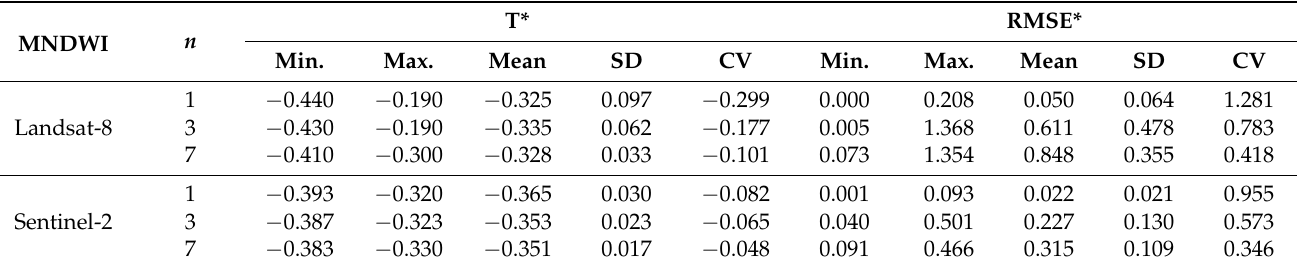
Table 2. Accuracy and threshold optimized statistics.